Question: Looking at the figure, what chart type is it?
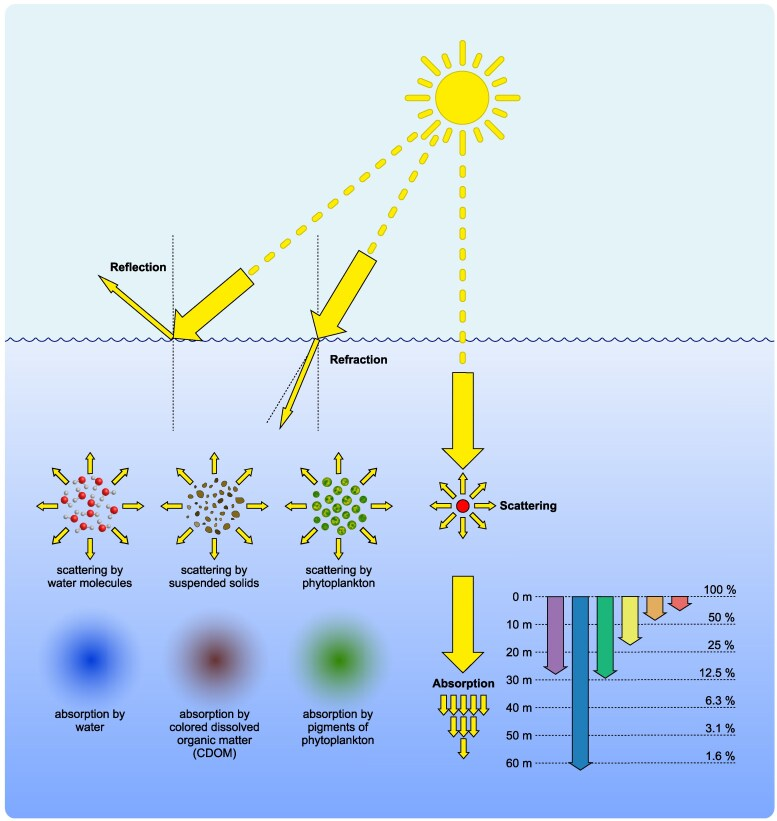
Answer: scatter